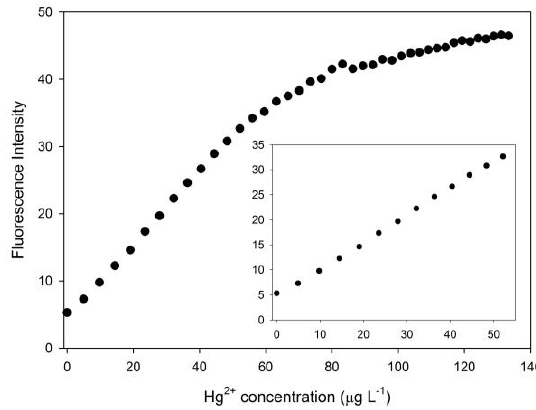
Figure 3. Fluorescence emission variations at 555 nm ( λ ex = 528 nm) of the sensor in the presence of increasing Hg 2+ concentrations. The linear region at low Hg 2+ concentrations is amplified in the inset.